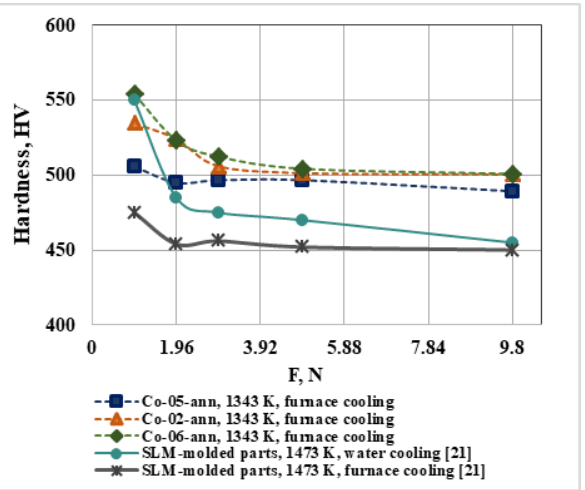
Figure 8. Influence of the conditions of heat treatment and cooling on the hardness of CoCrMo alloys under different loads.